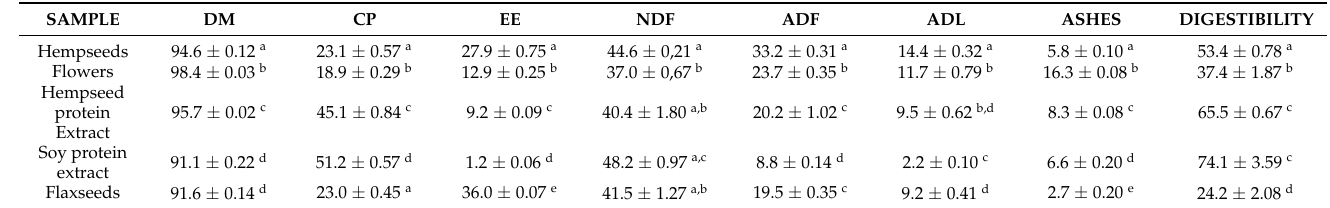
Table 1. Chemical composition and digestibility of study matrices (% w / w on DM basis). Data are presented as mean ± standard error of mean (SEM). ( n = 3). DM = dry matter; CP = crude protein; EE = ether extract; NDF = neutral detergent fibre; ADF = acid detergent fibre; ADL = acid detergent lignin. Different superscript letters in columns indicate statistically significant differences ( p <